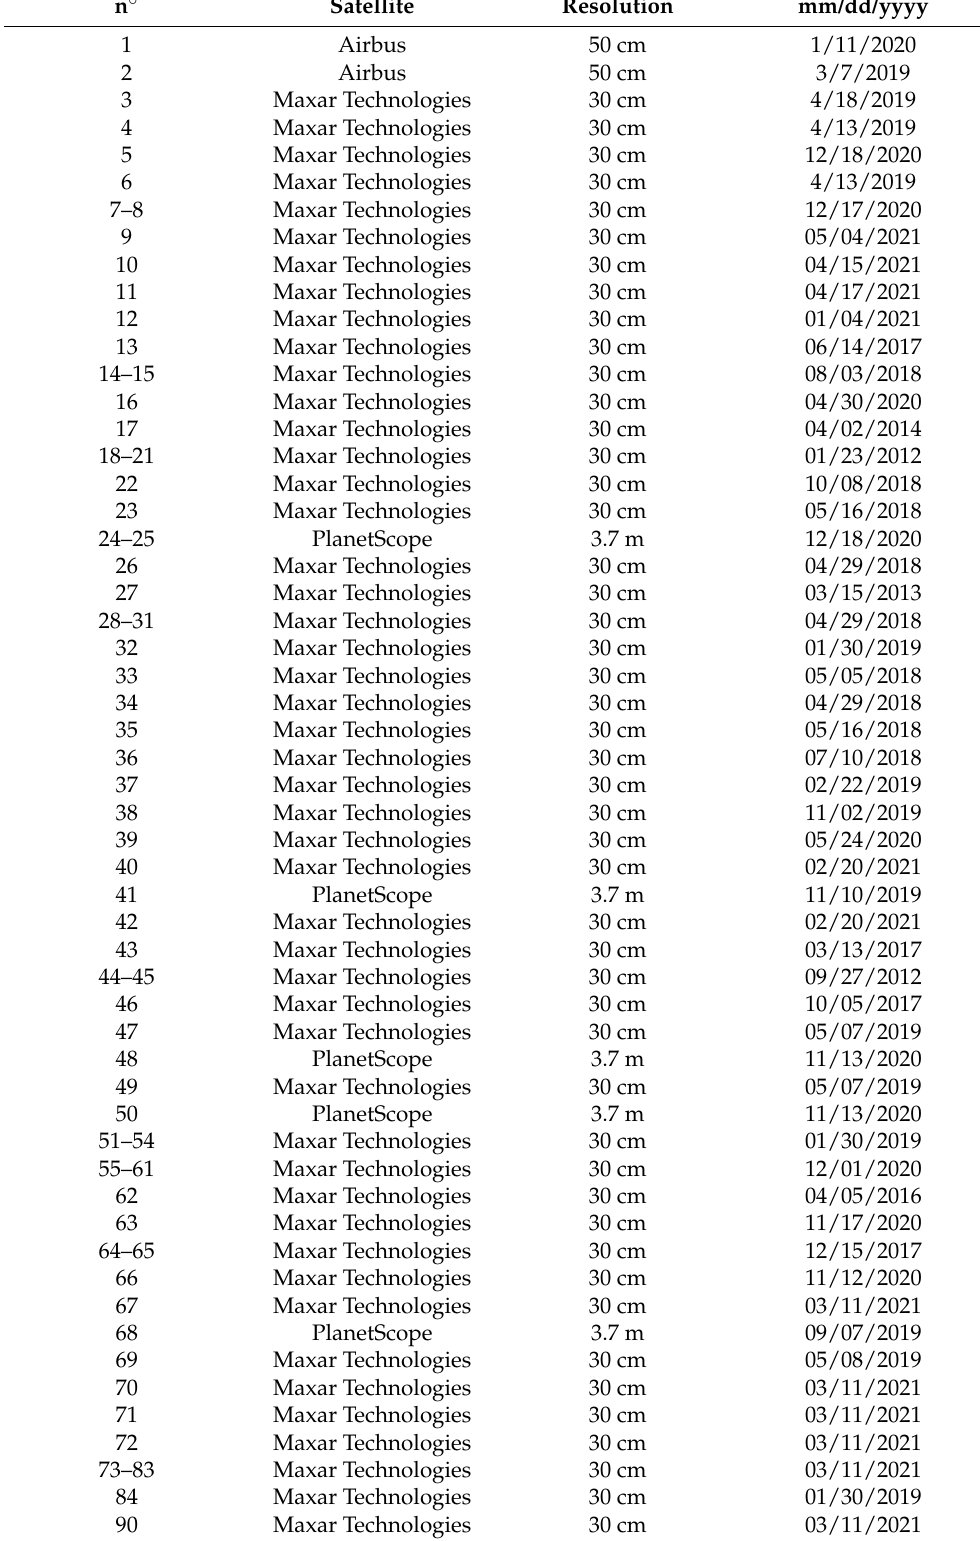
Table A2. List of the images used for the